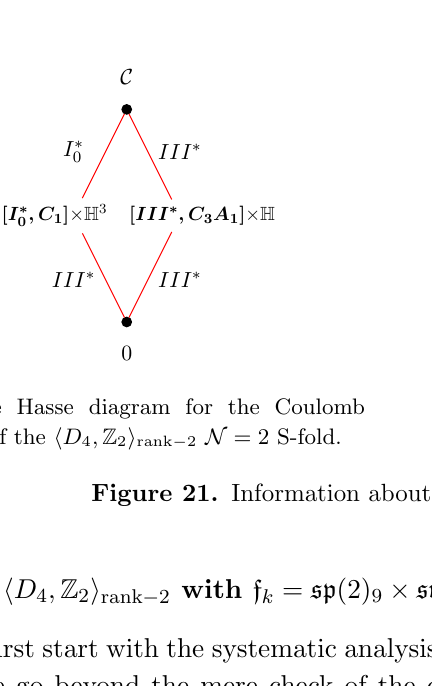
Figure 20. The Hasse diagram for the Higgs branch of the su (2) 8 (cid:2) sp (4) 6 theory.